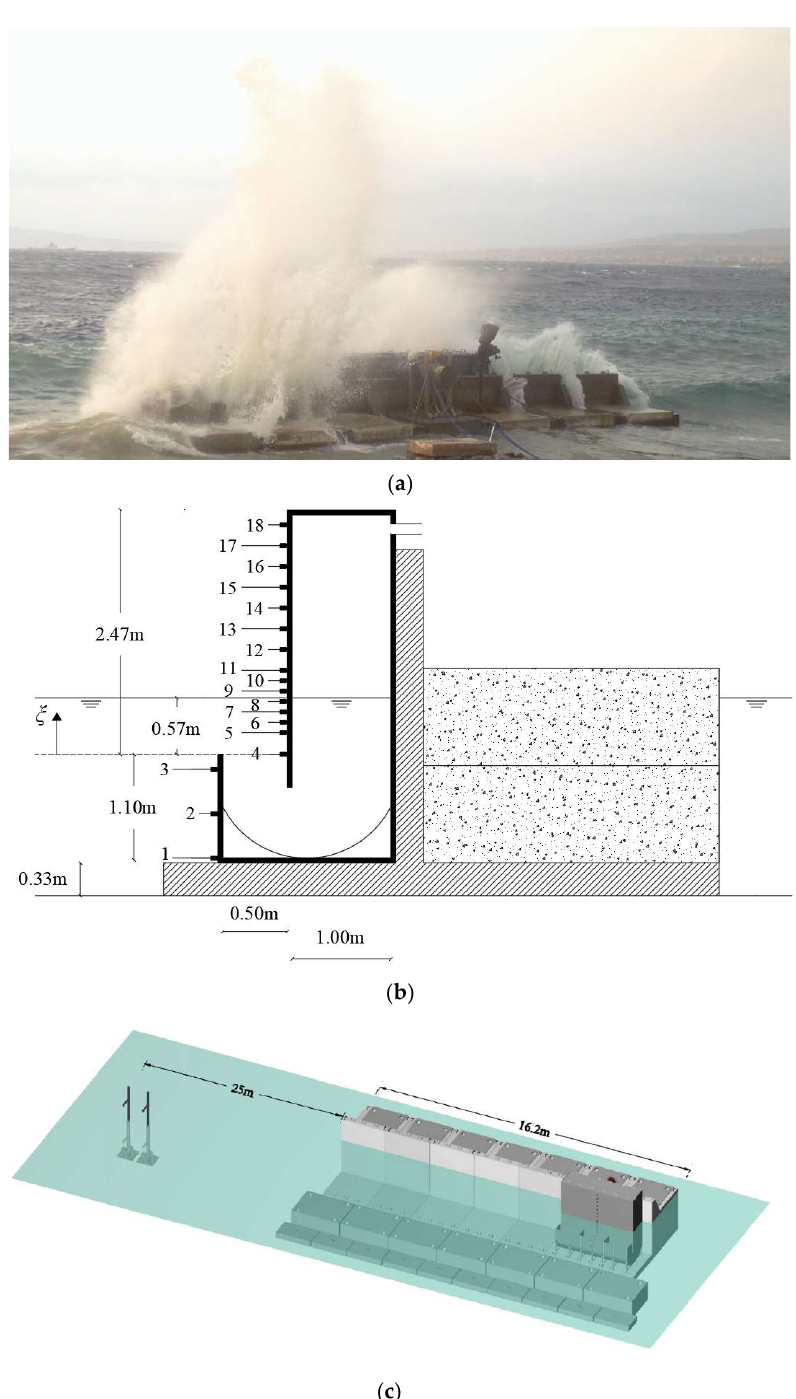
Figure 1. ( a ) The small-scale U-OWC breakwater at NOEL laboratory (off the beach at Reggio Calabria, eastern coast of the Strait of Messina) during a sea storm with the realization of an impact load on the structure; ( b ) Cross- of the U-OWC caisson equipped with pressure transducers (1–18); ( c ) Three-dimensional overview of the small-scale experiment at NOEL laboratory. A small-scale model (1:8 scale) of a U-OWC caisson breakwater has been installed in 2014 off the beach of Reggio Calabria in the Eastern coast of the Strait of Messina (Southern Italy), at the Natural Ocean Engineering Laboratory (NOEL) and the experimental activi- ties were carried out in 2015 (Figure 1). A peculiarity of the laboratory is that a local wind from NNW often generates sea states consisting of pure wind waves that represent a small-scale model of Mediterranean or Ocean storms, in the Froude dynamic similarity. The structure, completely made of steel, has been located in front of the reinforced concrete caisson (at the wave-beaten side, see Figure 1b) and structurally connected to the part in reinforce concrete. The “active” part is in steel and it is composed by the vertical U-duct and by the pneumatic chamber, connected to the atmosphere via an orifice. This model has a height of 2.00 m with respect to the mean water level, and the depth of the natural bottom is approximately 2 m. The width of the U-conduit is 0.5 m, while the pneu- matic chamber is 1 m wide. The variation of the water depth due to the tide is typically within ±0.15 m. The opening of the vertical duct is located at 0.57 m below the mean water level. On the top of the chamber, there is a tube with a horizontal axis, connecting the chamber to the atmosphere. For the small-scale field experiment, the cross-section of the central U-OWC caisson was equipped with a vertical row of 18 pressure transducers allowing the measurement of the wave pressure, and thus of the horizontal wave force, acting on the U-OWC break- water. Pressure transducers were numbered from 4 to 18, from the opening of the vertical duct to the top of the U-OWC (see Figure 1b). Then, three transducers (from 1 to 3) were located along the external wall from the opening to the bottom. The center distance of the pressure transducers is: 0.21 m from 11 to 18, 0.15 m from 4 to 11, while 0.45 m from 1 to 4. 2.2. Characterization of Incident Wave Field during Experiment The free surface elevation and wave pressures of the incident waves were calculated through a set of instruments, located in the undisturbed wave field, far from the structure. They were placed on two thin vertical piles positioned 25m from the U-OWC breakwater, each equipped with a couple of an ultrasonic probe and a pressure transducer (see Figure 1c). The accuracy of wave pressure transducers is 0.5% SB (scale bottom error). During the experiment, a set of more than 250 records of pure wind waves were recorded from March to October 2015. The duration of each record was 5 min, with a sampling rate of 10 Hz. As shown by Peregrine [5] and Boccotti et al. [7], 10 Hz is a sufficient sampling rate for the identification and characterization of impact wave loads